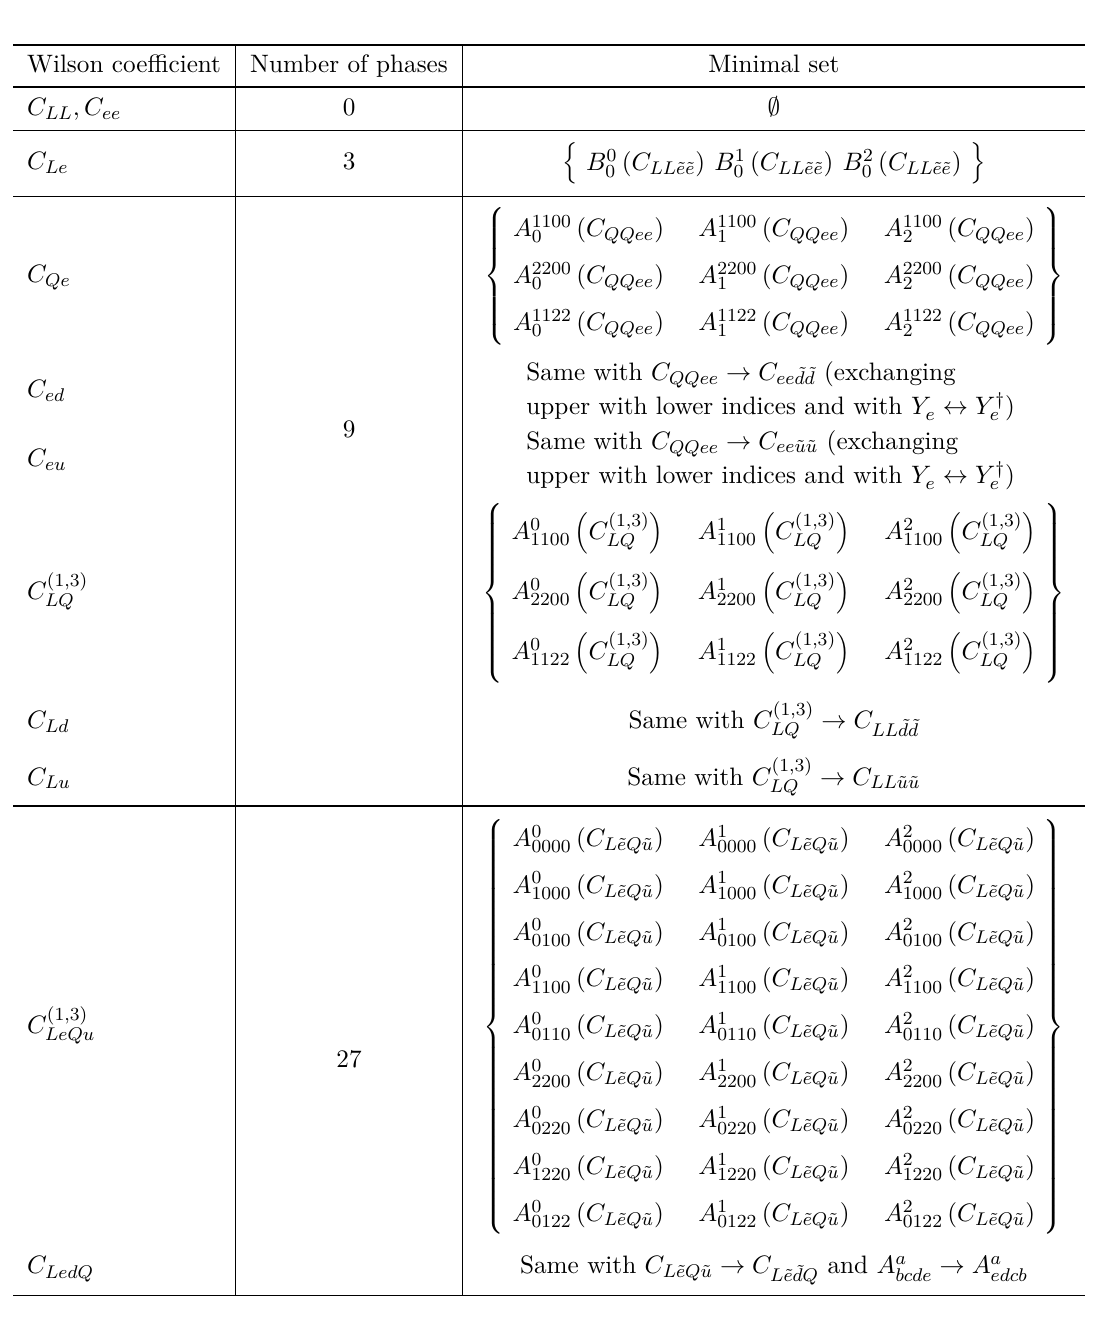
Table 11 . Minimal sets of CP-odd flavor invariants for all the SMEFT dimension-six Wilson coefficients associated to operators quartic in fermion fields (continued in tables 12, 13). We recall that X u ≡ Y u Y † traces introduced in eq. (4.8), as well as the compact notations in eqs. (4.9)–(4.10). We also defined for the leptons A a